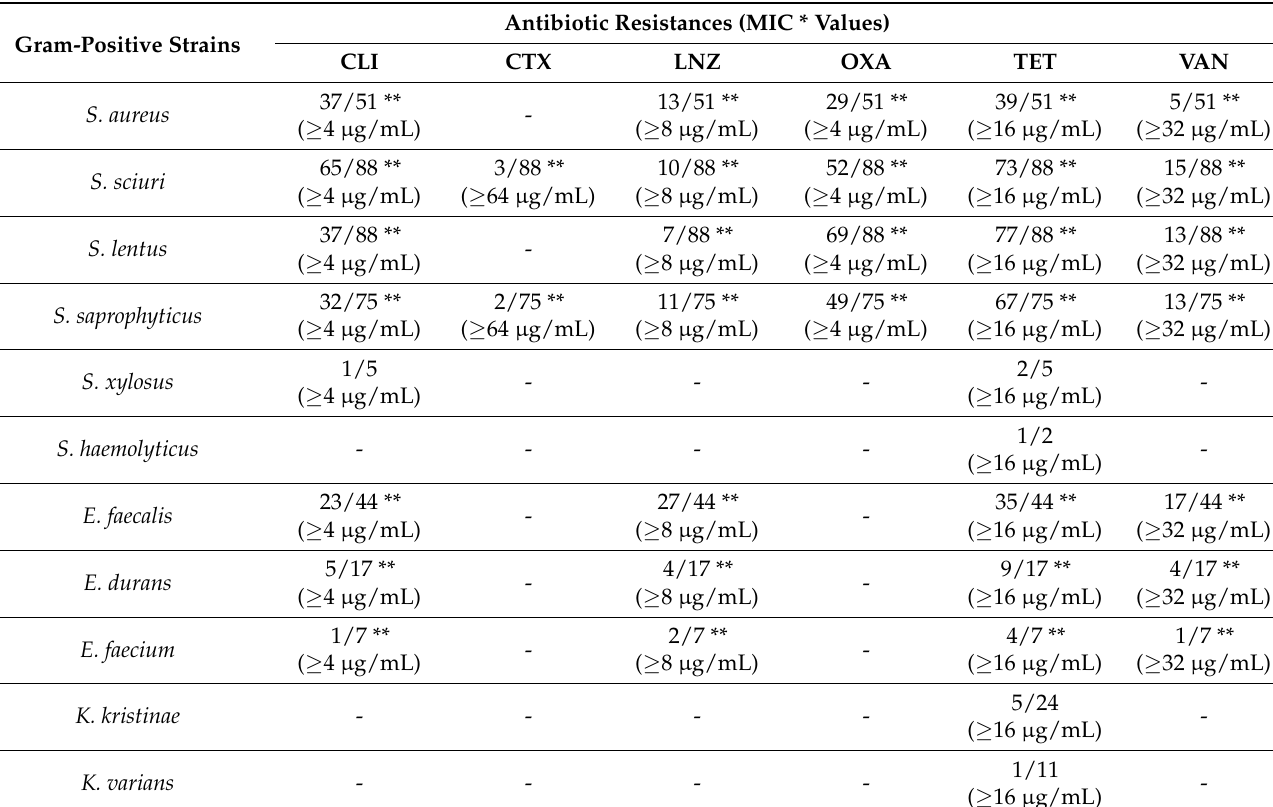
Table 6. Gram-positive bacterial strains: the phenotypic resistance